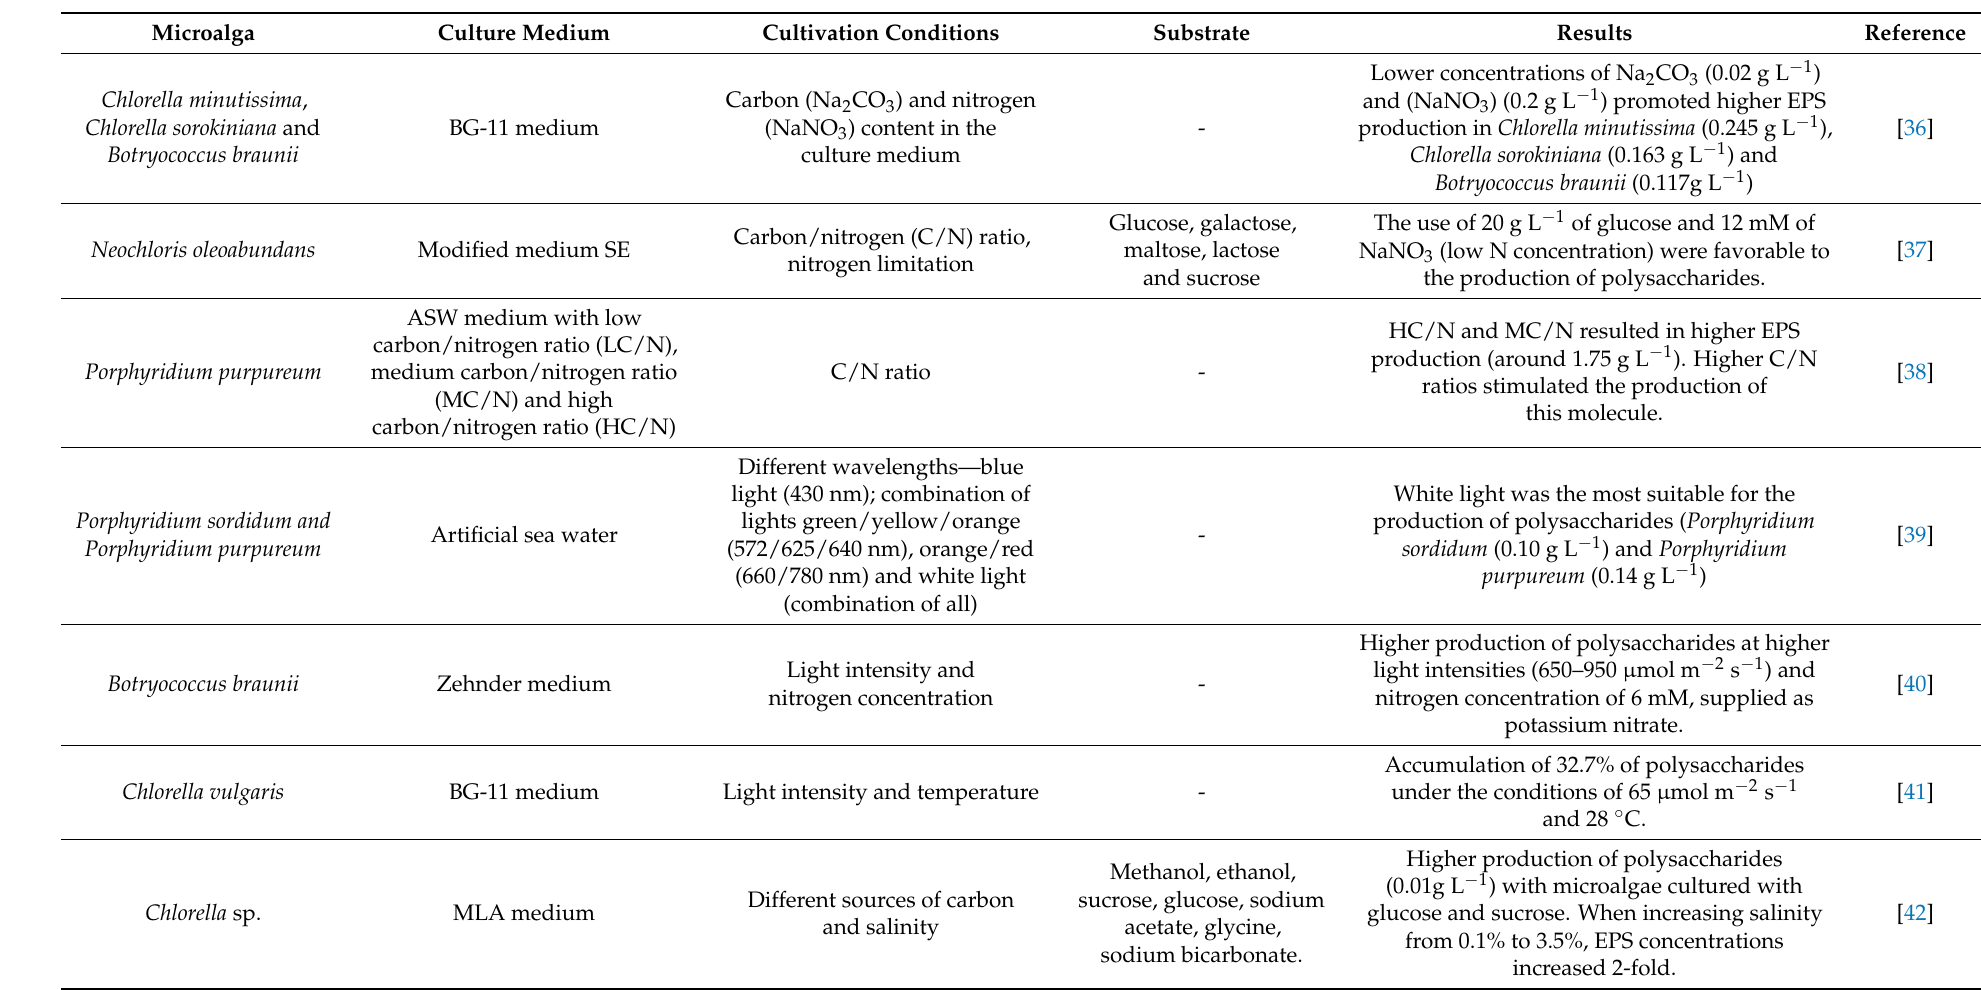
Table 2. Production of polysaccharides by microalgae and influence of cultivation